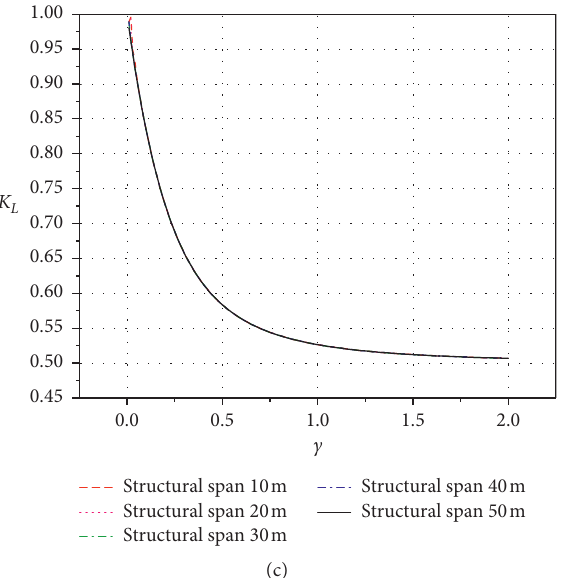
Figure 13: Equivalent load transformation factors of one-way members using Henrych’s formula parameters in plastic stage: (a) W � 1kg. (b) W � 10kg. (c) W � 100kg.